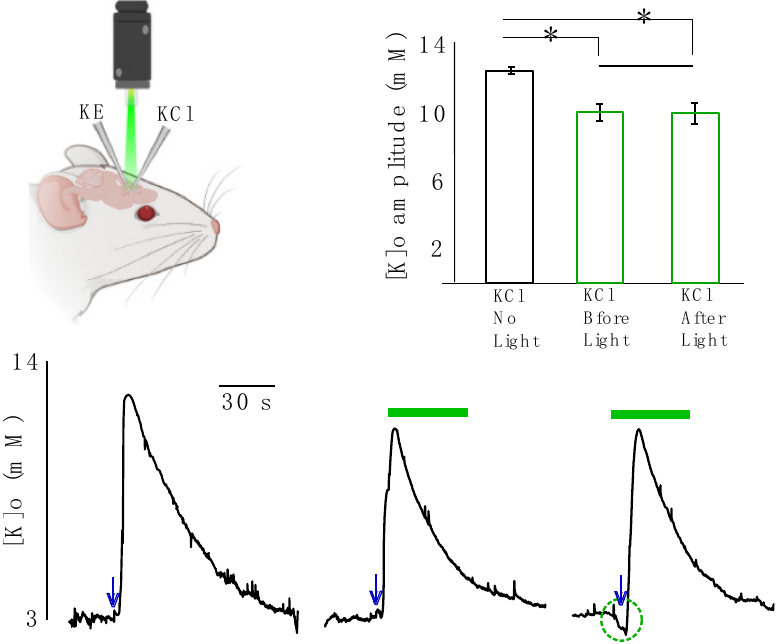
Figure 3. Effect of light application on focally evoked K responses (using KCl injection). KCl was focally applied either without any light, before light onset or after light onset. Top left: a K-sensitive recording electrode (KE) and a KCl injection micropipette (KCl) were implanted in the transfected area. Top right: changes in the amplitude of the evoked K response are summarized, black: in the absence of light. Green middle column: KCl was applied before light onset. Green right column: KCl was applied after light onset. * Represents significance ( p < 0.05). Bottom: evoked K responses. Left: in the absence of light. Middle: KCl was applied before light onset. Right: KCl was applied after light onset. The green bar represents green light application, navy arrows represent time of KCl injection.